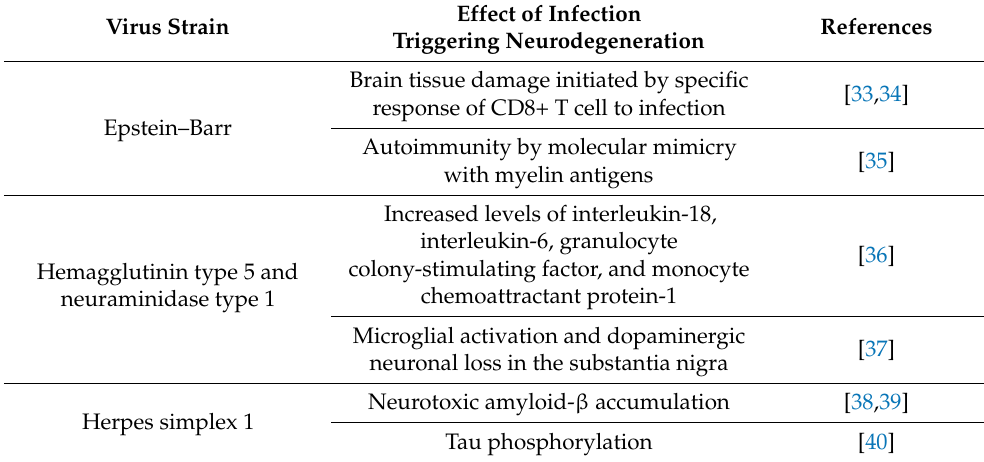
Table 1. Viral infections and